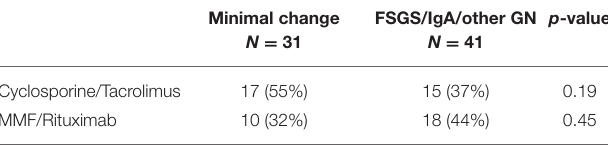
TABLE 4 | Biopsy results in relation to the treatment regimen.